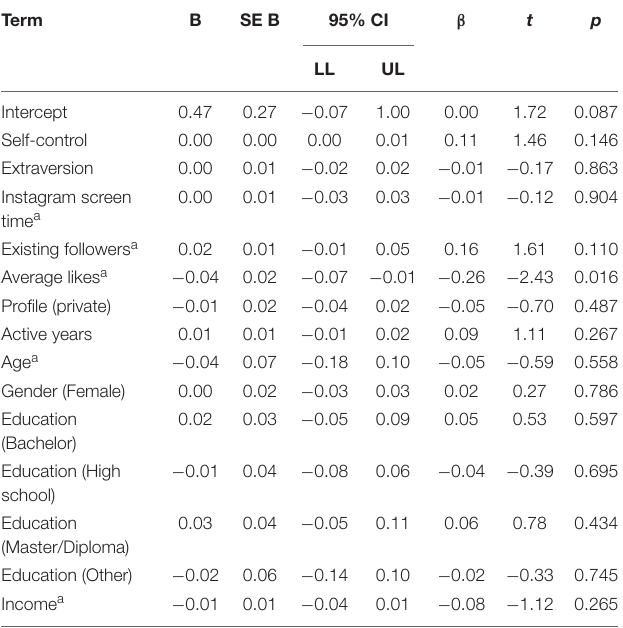
TABLE 3 | Multiple regression analysis of LDR